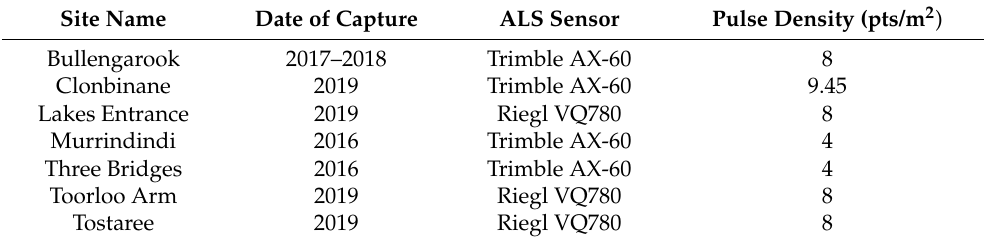
Table 2. Properties of the Airborne Laser Scanning data collected at seven